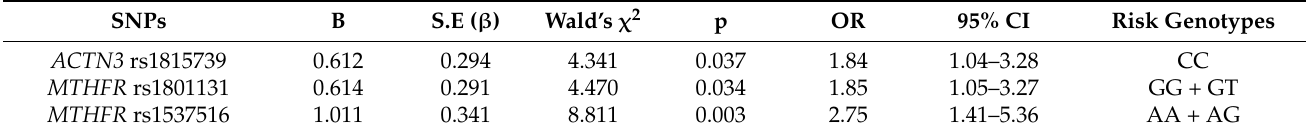
Table 3. Association of single-nucleotide polymorphisms with sarcopenia in obese